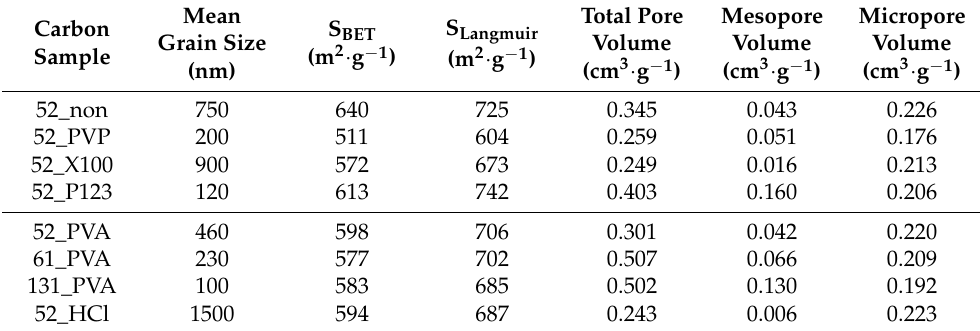
Table 1. Textural parameters of the resol resin-derived carbon materials carbonized at 600 ◦